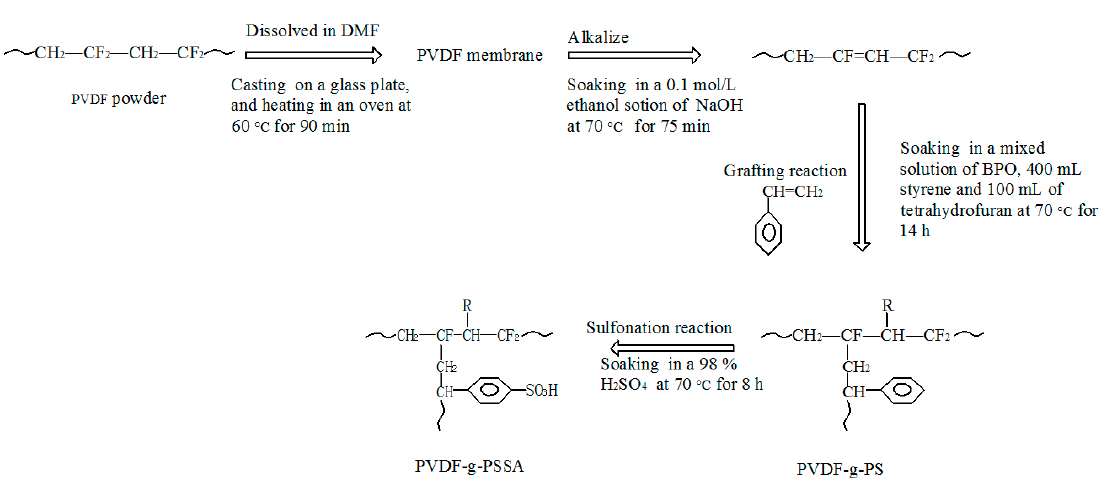
Figure 1. The membrane preparation principle.